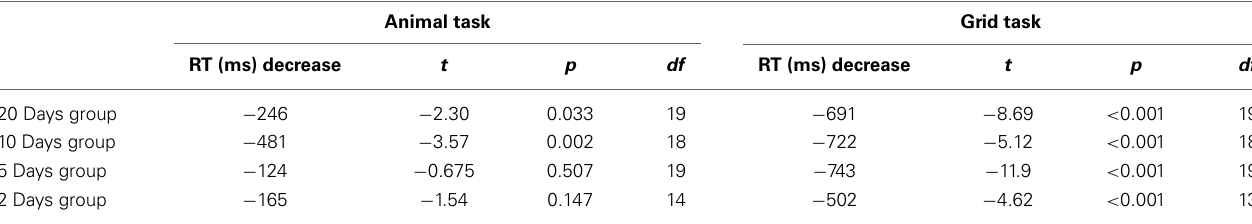
Table 1 | One-sample t -test showing training gain of the four training groups as measured by the presentation time decrease (the average of the last three sessions minus that of the first three